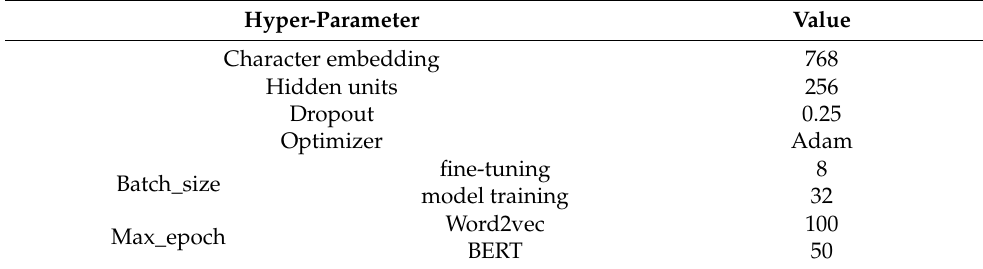
Table 2. Parameter settings for ACE-ADP